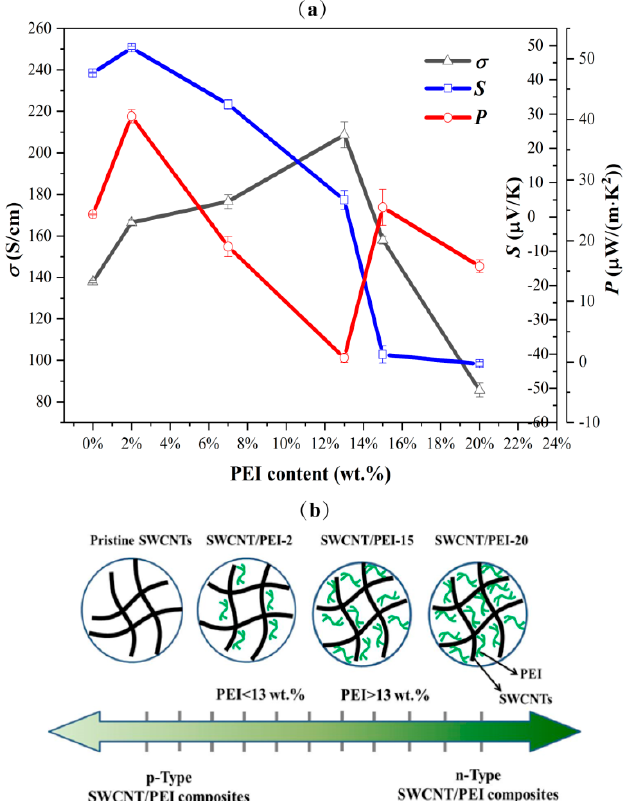
Figure 5. ( a ) The influence of PEI content on the thermoelectric properties of SWCNT/PEI composites.